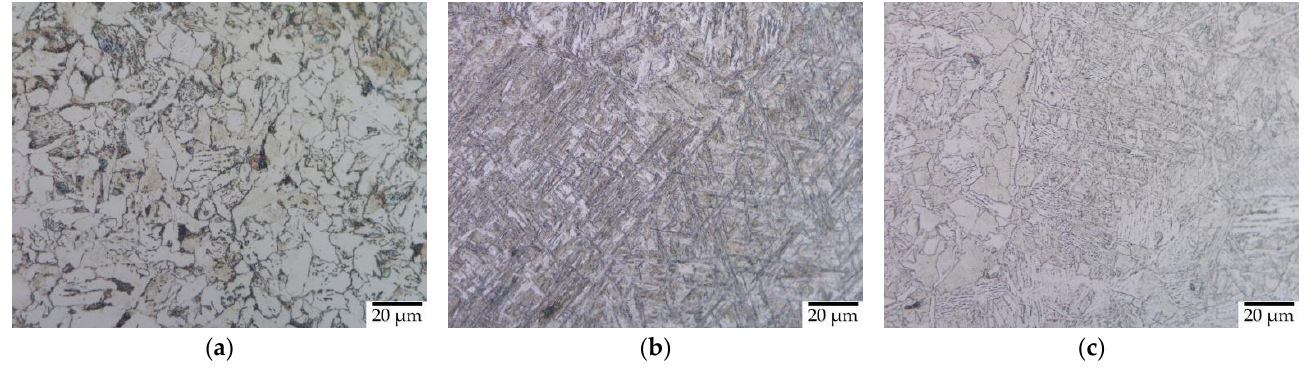
Figure 4. Microstructure of ( a ) original (O), ( b ) quenched (Q), and ( c ) tempered (T) samples by HT1.